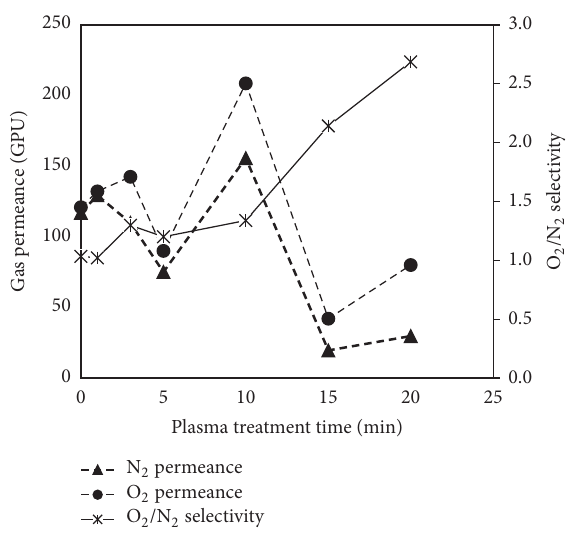
Figure10:O 2 andN 2 gasespermeanceandidealO 2 /N 2 selectivityat a pressure of 3 bar for plasma treated PSF membrane with different treatment